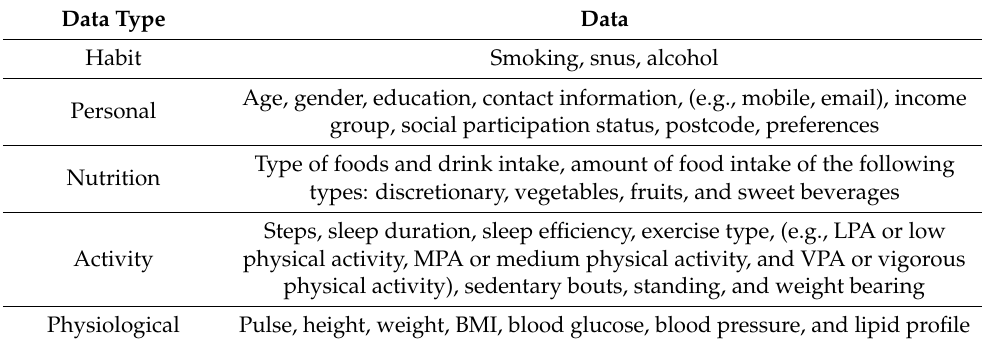
Table 3. The approved list of personal and person-generated health